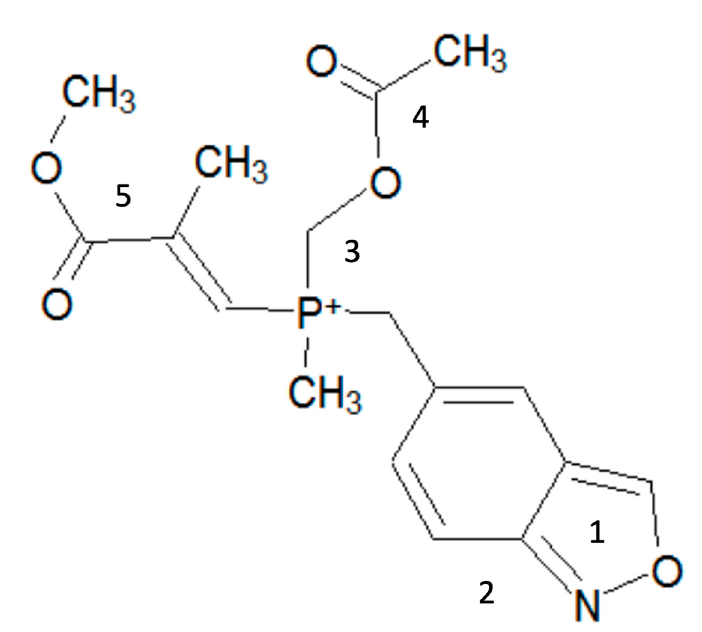
Figure 2. Virtual poly-clastogens derived from OFGs related to misleading positives. Poly-clastogens for in vitro-specific positives are described in Table 3. The names of OFGs are as follows: (1) Oxazole/Izoxazole, (2) Benzthiazolinone/Benzoisothiazolinone, (3) Phosphonium and salt, (4) Acetoxy, and (5) Methacrylate.